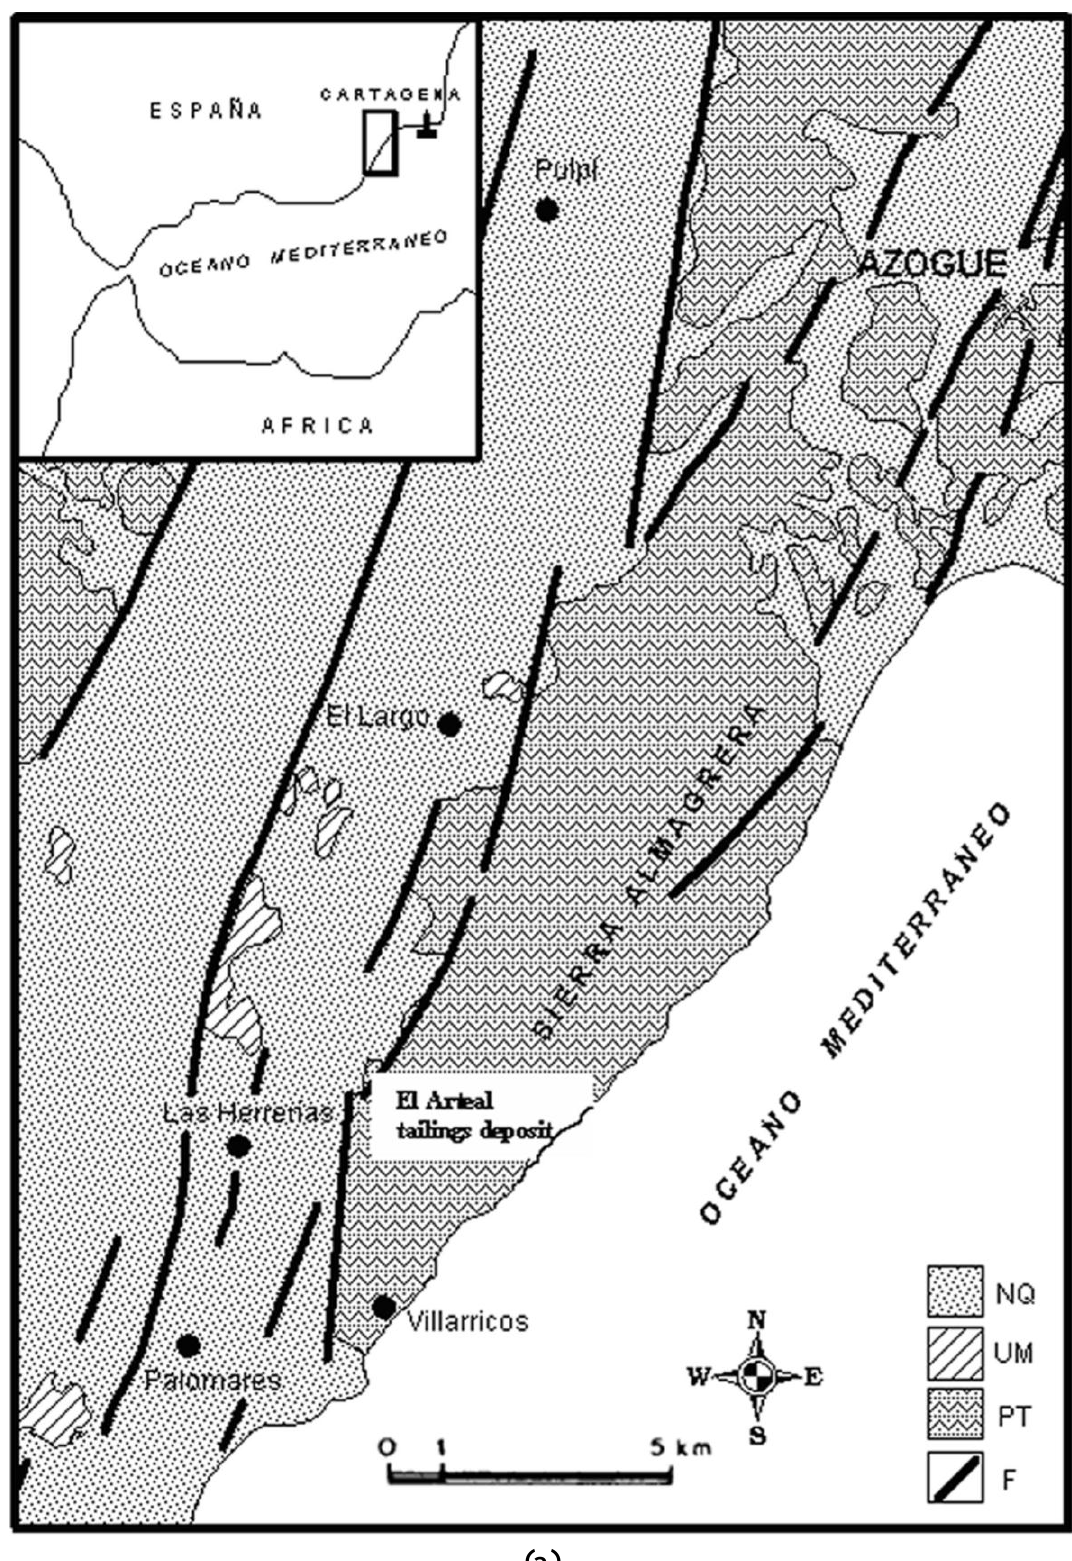
Figure 1. ( a ) Location of the study area and regional Geology. NQ: Neogene and Quaternay; UM: Volcanic-shoshonitic rocks of Miocene age; PT: Metamorphic basement; F: Main fractures. ( b ) Detail of smelting slags dumps in Sierra Almagrera (Almería, Spain). ( c ) Detail of the experimental